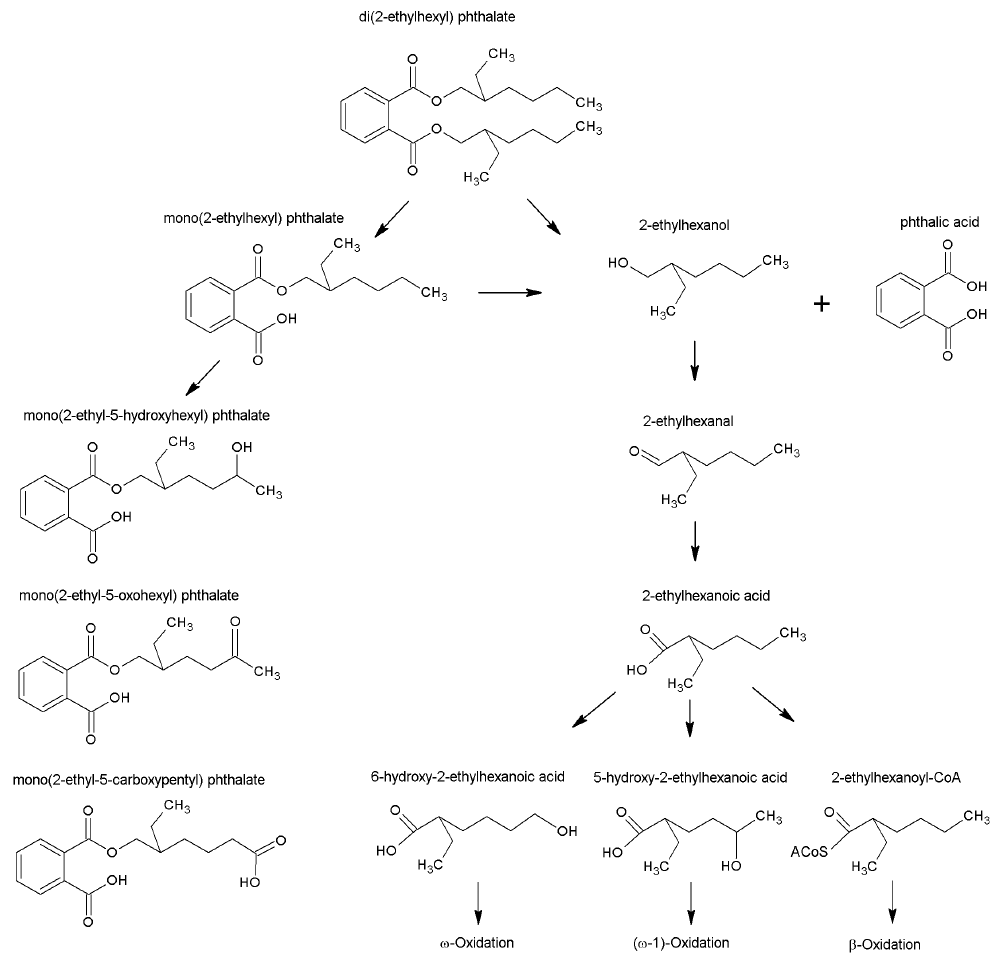
Figure 1. Metabolic fate of DEHP and its metabolites. Pathways are adapted from Albro [36]; Deisinger et al. [39]; Koch et al. [1]; and Rusyn et al. [40].